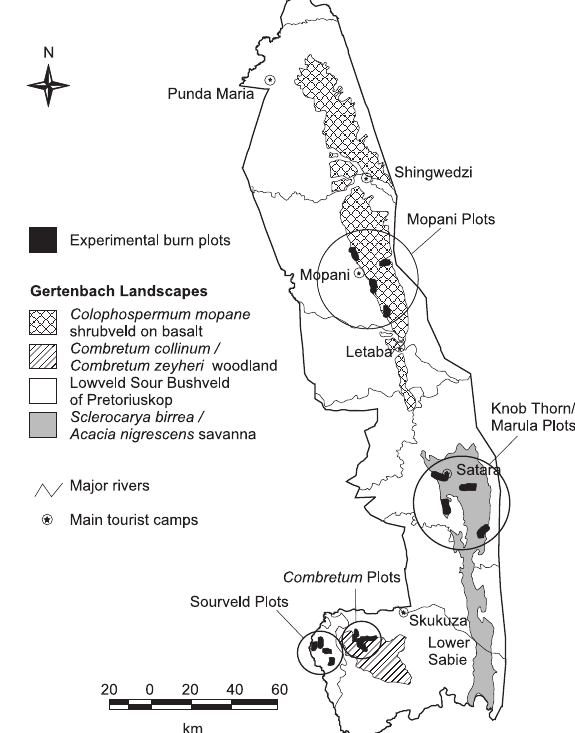
Fig. 1: The trial consists of four replicates (strings of plots) in each of four major vegetation landscapes in the park. Each repli- cate consists of 12 (Sourveld and Combretum replicates) or 14 (Knobthorn/Marula and Mopani replicates) plots, each of which receives a unique fire treatment (see Table